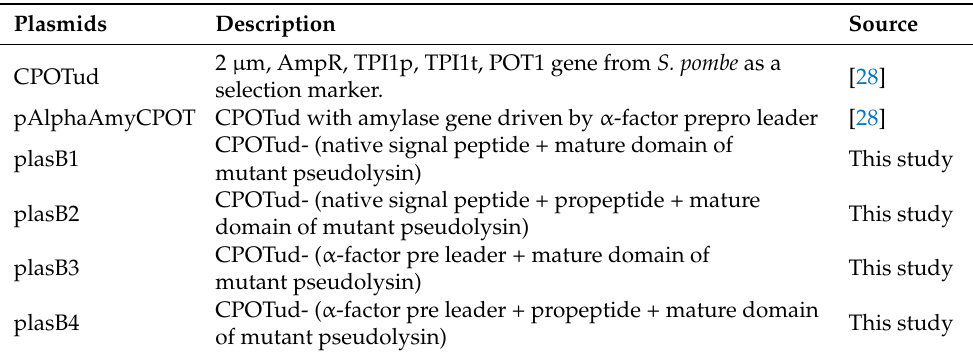
Table 1. Plasmids used in this